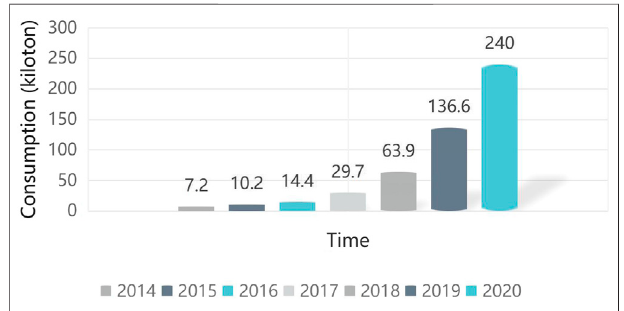
FIGURE 1 | Number of decommissioned lithium batteries in